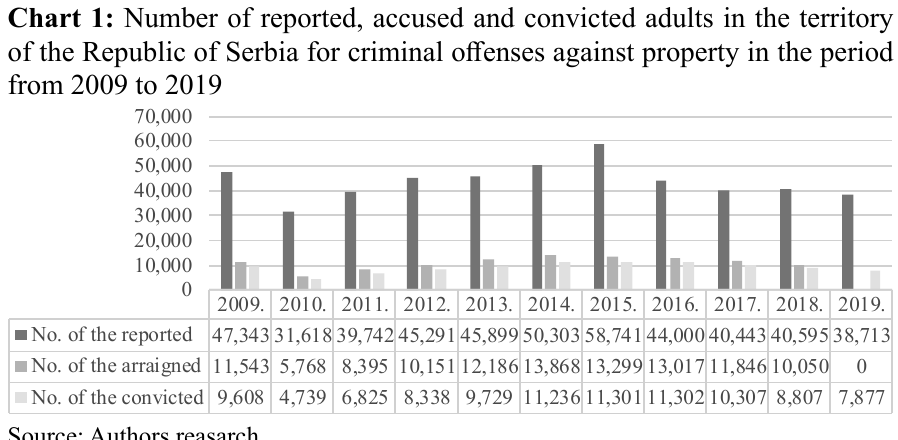
2009. 2010. 2011. 2012. 2013. 2014. 2015. 2016. 2017. 2018. 2019. No. of the reported